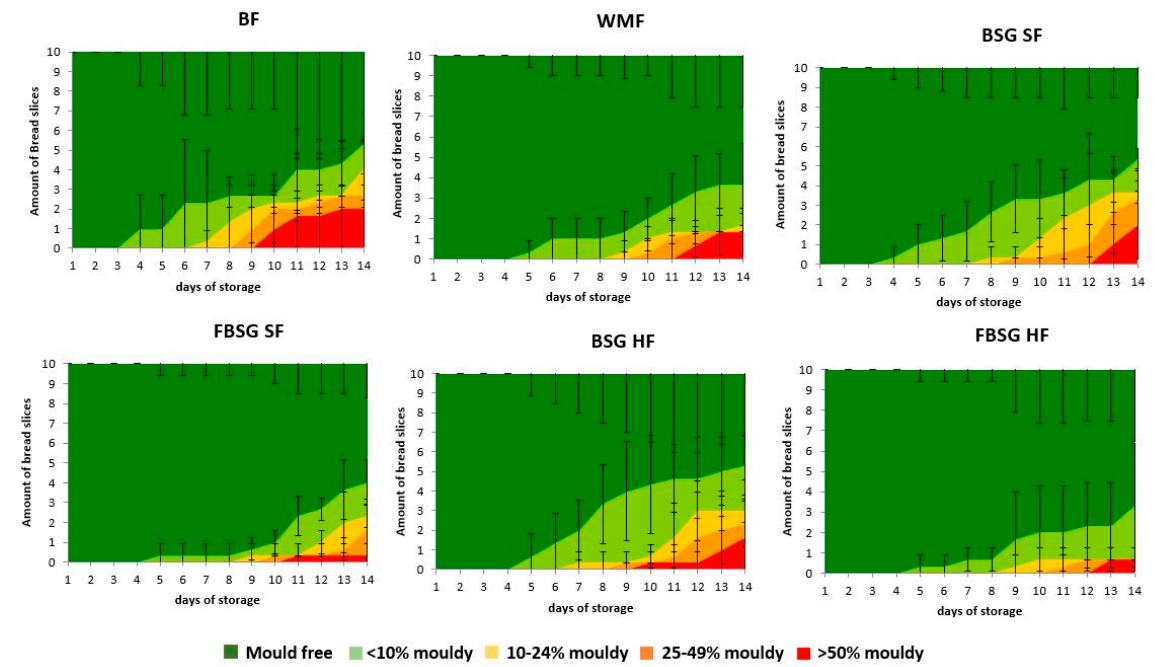
Figure 3. Shelf-life plots from 14-day analysis of breads. The amount of bread slices which contained each mould group (“mould free, <10% mouldy, 10–24% mouldy, 25–49% mouldy and >50% mouldy) was counted over a period of 14 days. BF and WMF represent baker’s flour wheat control and wholemeal bread, respectively. BSG and FBSG denote brewers’ spent grain and fermented brewers’ spent grain breads, respectively. SF and HF stand for “source of fibre” and “high in fibre” addition levels, respectively. The graph represents mean values obtained across three independent batches with standard deviations included as error bars.